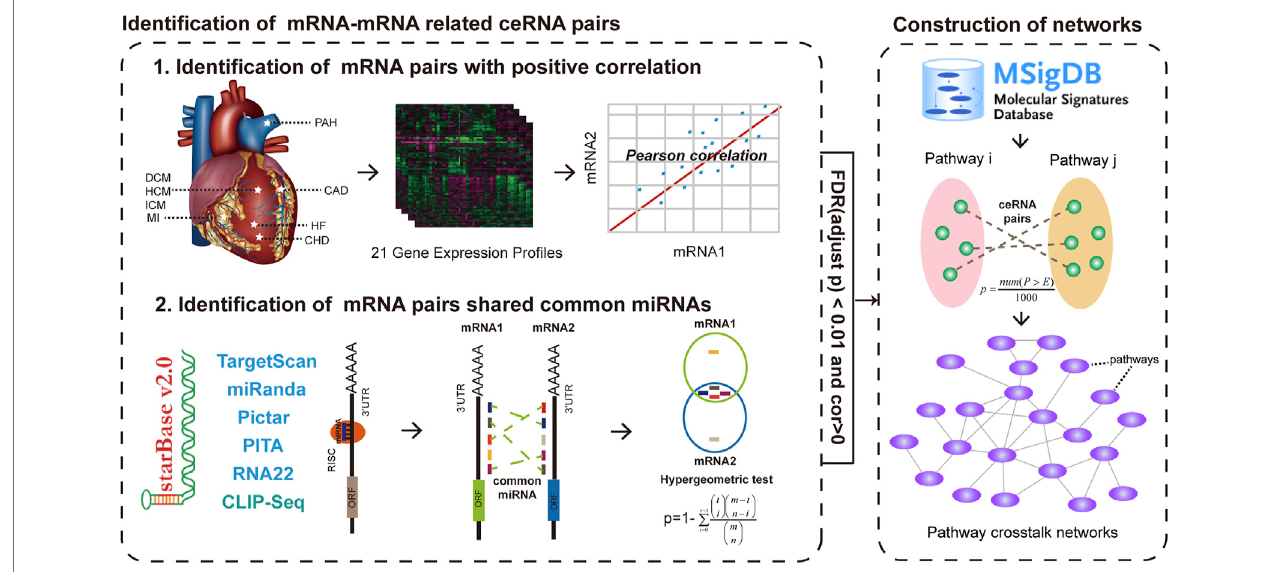
FIGURE 1 | Global work fl ow for construction of ceRNA-mediated pathway crosstalk networks of eight major CVDs. After identifying ceRNA crosstalk pairs by integrating gene expression and hypergeometric test in each gene expression pro fi les, we mapped these ceRNAs into the pathways that were downloaded from MSigDB. All candidate pathway crosstalks with a p value < 0.01 after 1,000 times permutation were identi fi ed as pathway crosstalks. Then, 21 CVD-related pathway crosstalk networks were constructed.